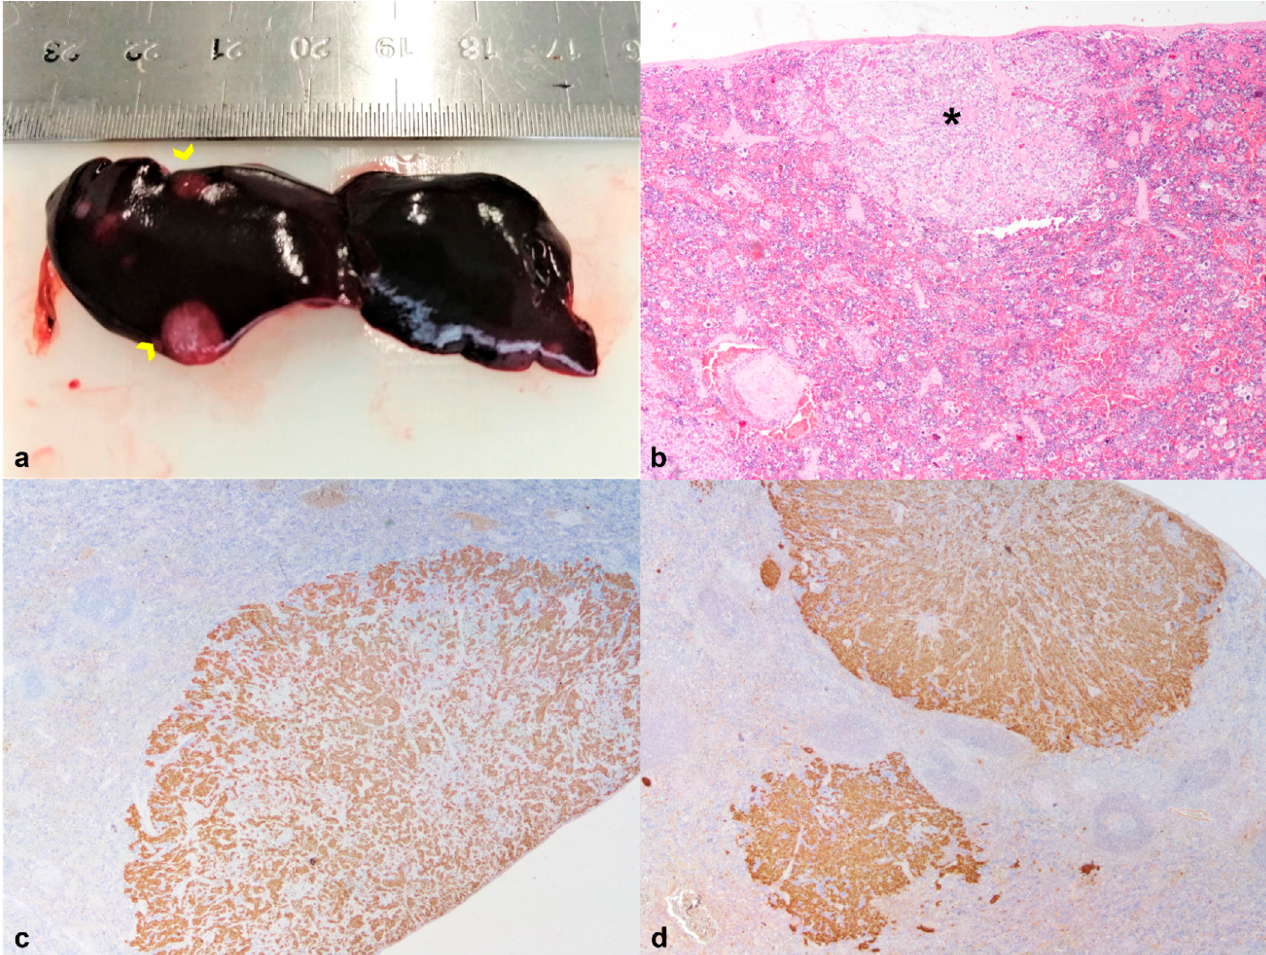
Figure 7. African pygmy hedgehog, spleen. Case 2, Metastases of a thyroid carcinoma. ( a ) Presence of several white-gray nodular masses, measuring 1.0–5.0 mm diameter (yellow arrows). ( b ) Well- demarcated nodular lesion (*) composed of neoplastic epithelial cells arranged in a solid pattern (HE, 20×); ( c , d ) The great majority of neoplastic cells showed strong immunoreactivity for pan-cytokeratins (AE1/AE3) and thyroglobulin (20×).